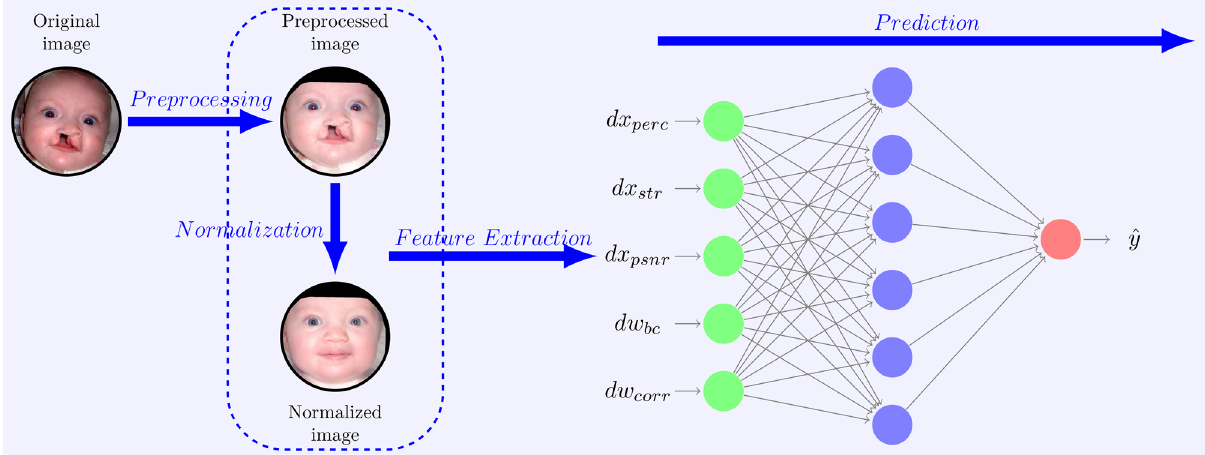
Figure 1. General signal flow and high level architecture of the study model demonstrating the four key steps: preprocessing, normalization, feature extraction, and prediction. As a first step, preprocessing is applied to the original image to obtain a cropped, aligned and masked image. Then, the preprocessed image is normalized by preserving its unique characteristics and filtering out any structural anomalies. As a next step, features are extracted by measuring the distances between normalized and preprocessed images and latents both in the image space and in the latent space. While the features dx perc , dx str , and dx psnr denote the perceptual distance, structural distance, and PSNR distance in image space, dw bc and dw corr denote Bray–Curtis distance and correlation distance in latent space, respectively. After retrieving the representative features, human rating is predicted ( ˆ y ) using the MLP regressor with only one hidden layer having 6 neurons. Original image, reference 37